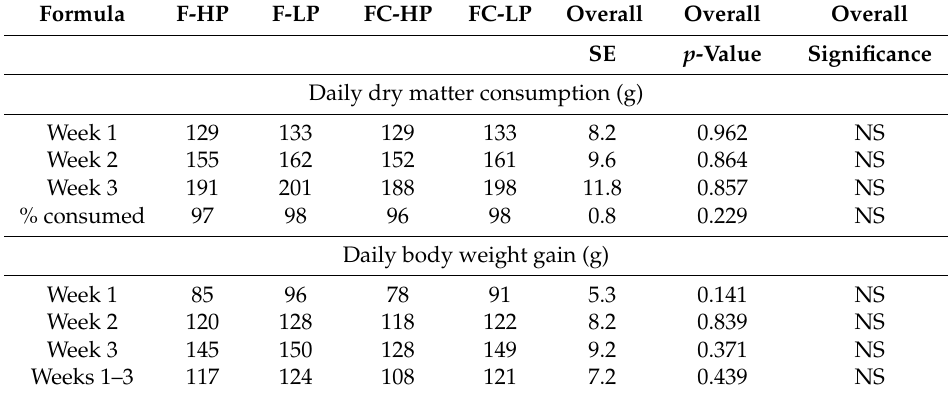
Table 2. Mean daily dry matter intake and daily body weight gain for the piglets receiving the test infant